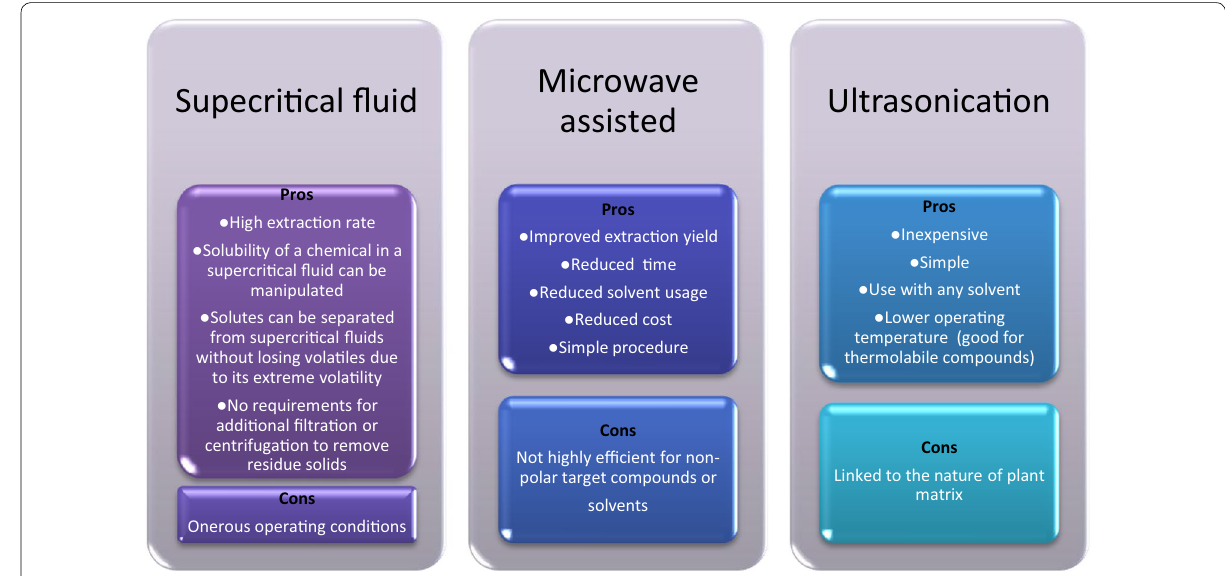
Fig. 6 Advantages and disadvantages of grape pomace non-conventional extraction